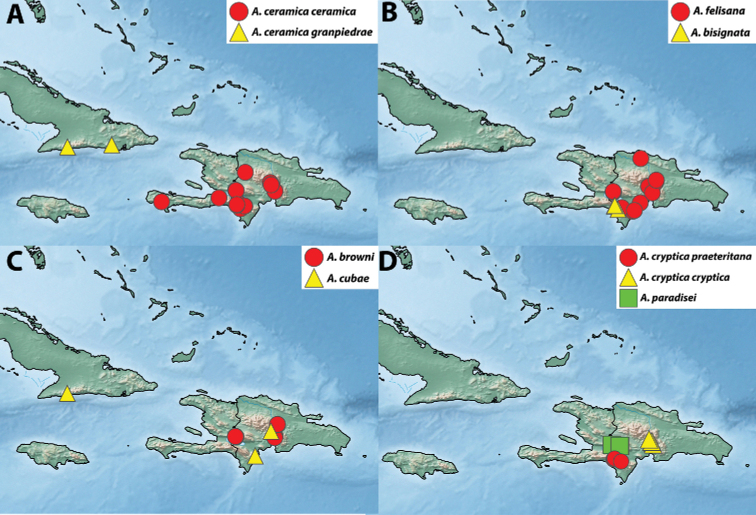
Argyrotaenia species distributions. Legends inset.